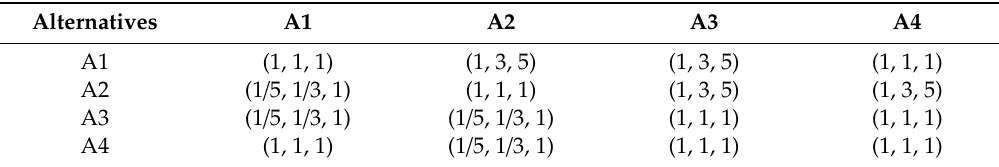
Table 19. Evaluation with respect to the mitigation time.